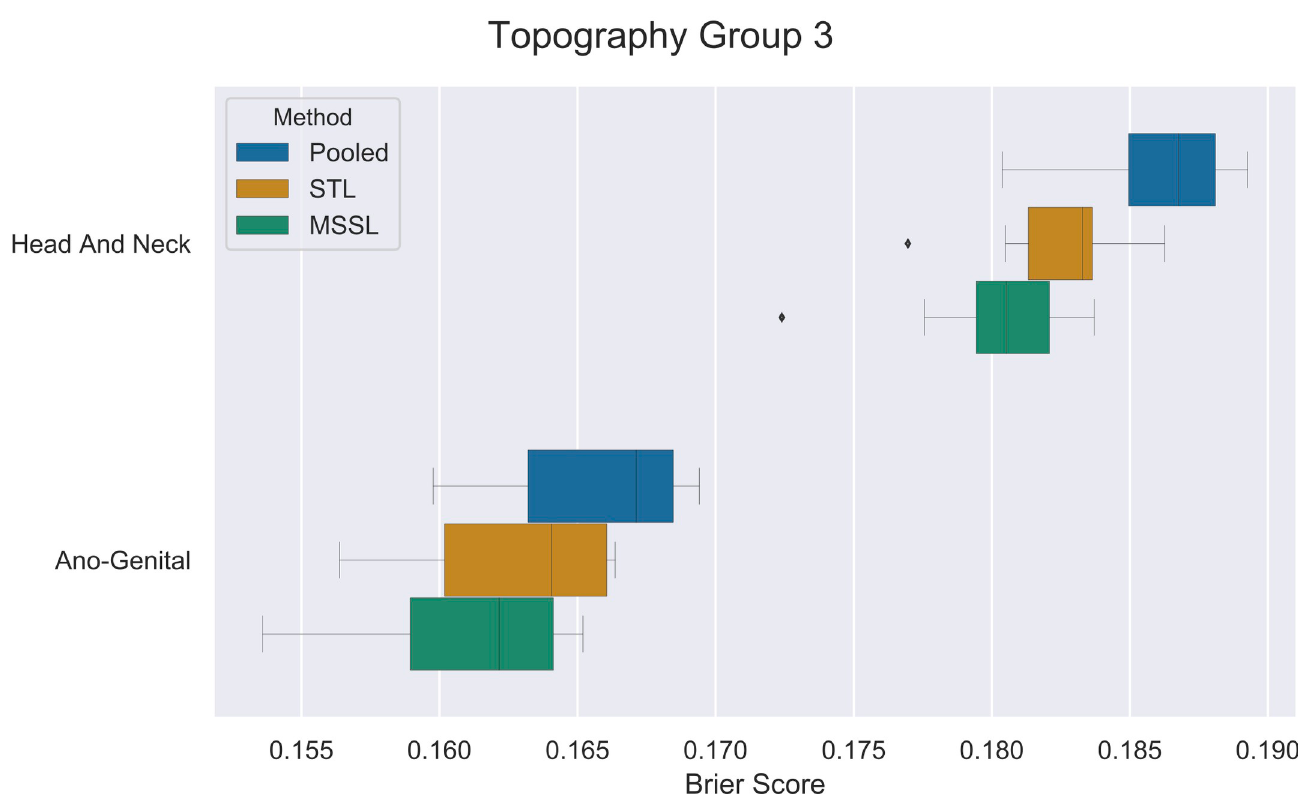
Fig 4. Brier scores (x-axis) for pooled, STL, and MSSL classifiers for Topography group 3 data split. Boxplots show results from 30 independent runs.